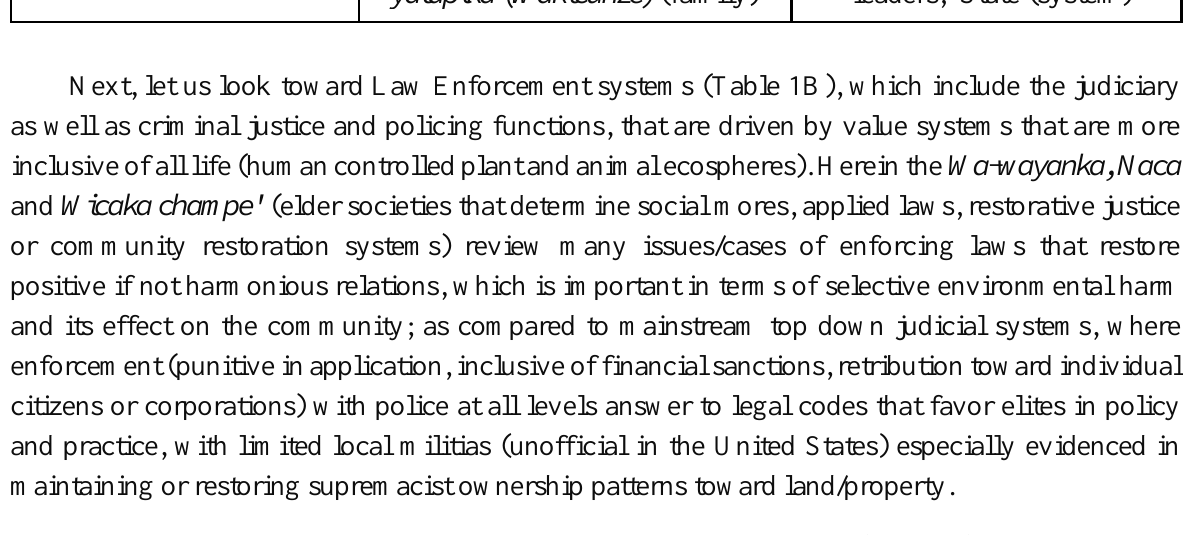
Table 1B. Law Enforcement Social Sphere (isolated)